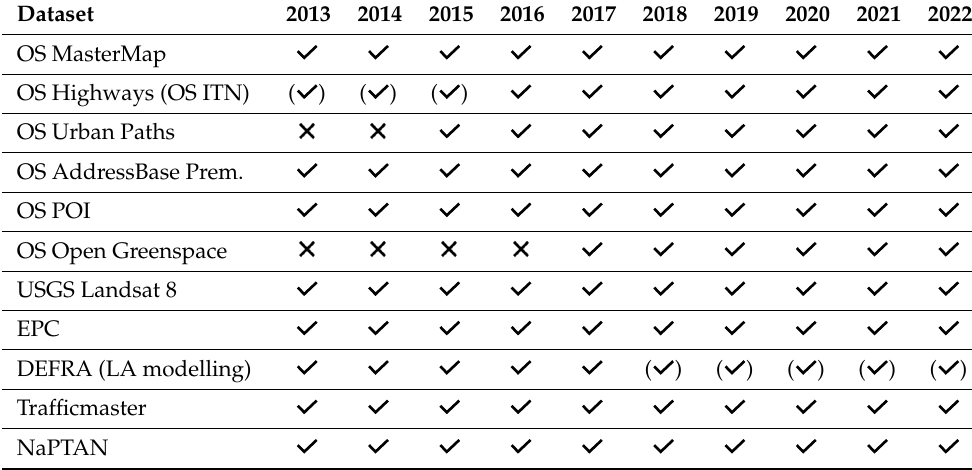
Table 3. Overview of available datasets by year.